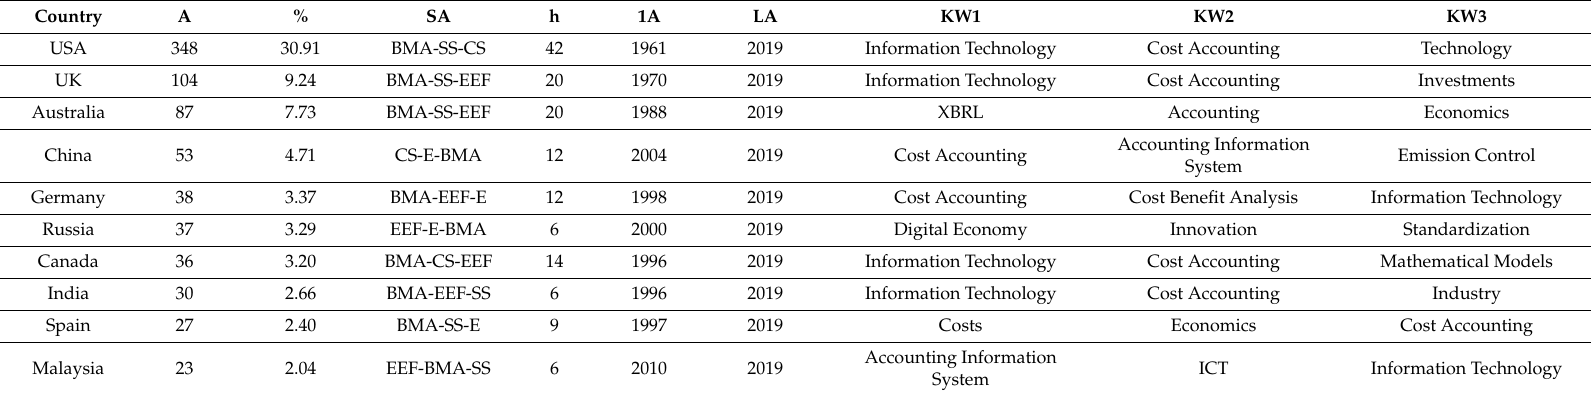
Table 4. Top 10 countries